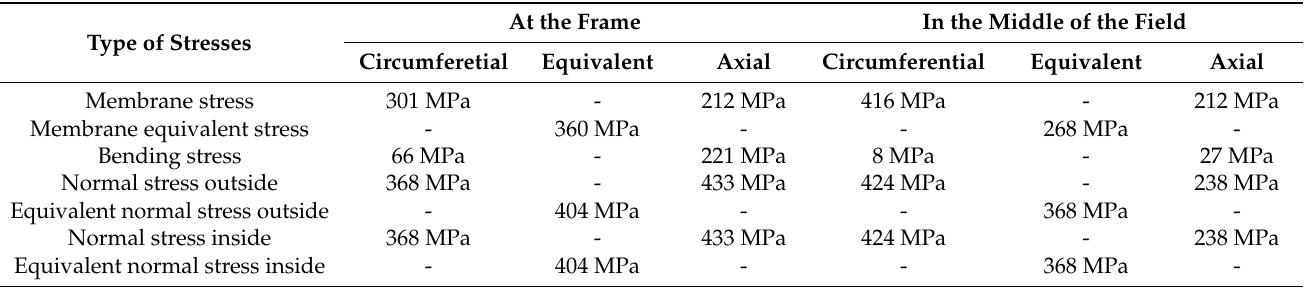
Table A5. Stresses at the collapse diving depth for the SFG baseline design in the flooded